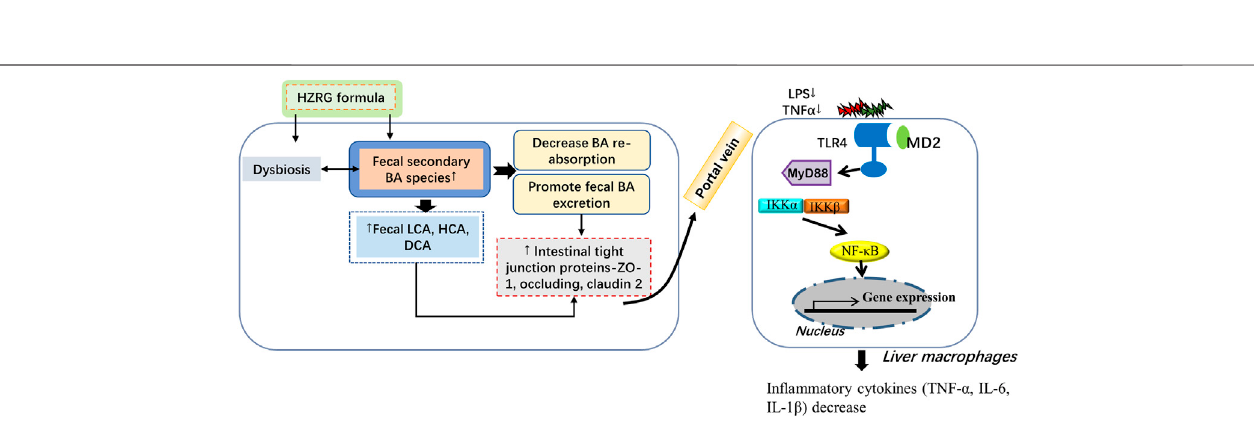
FIGURE 7 | Graphic summary of the